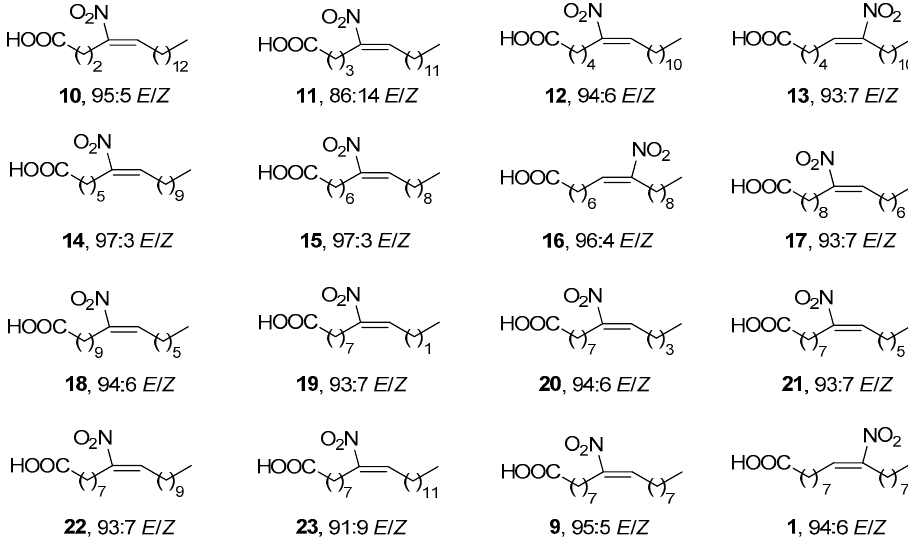
Figure 6. New NO 2 -FAs for SAR